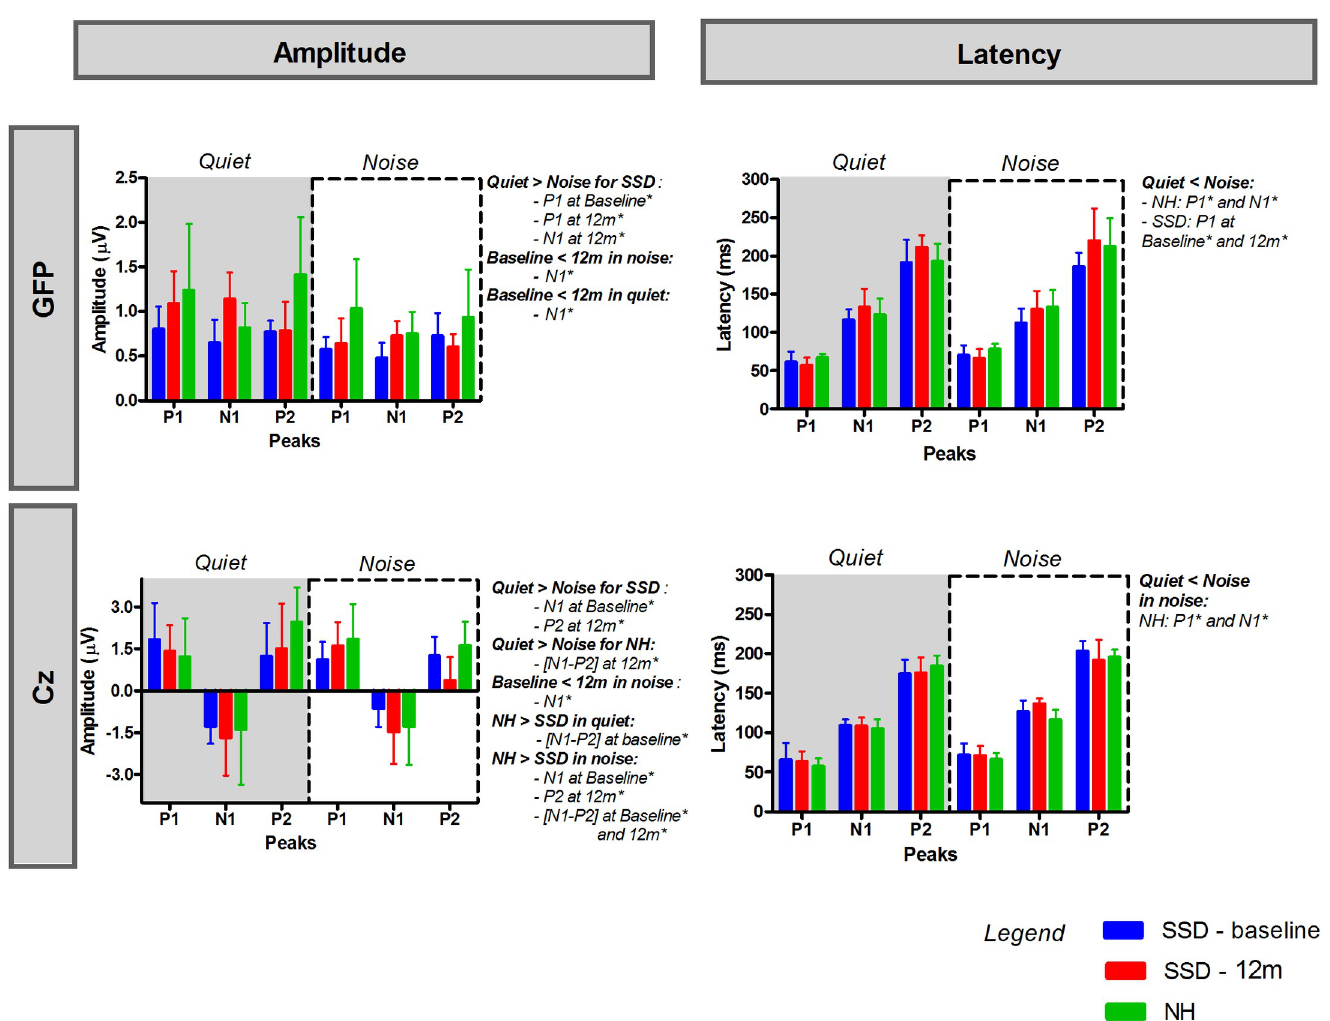
Fig 3. Mean peak amplitude and latency for GFP (top panels) and at Cz (bottom panels) in quiet (grey panels) and in noise (white panels) for SSD-CI participants at baseline (blue) and 12m post-activation (red) and for the NH control group (green). The error bars show the standard